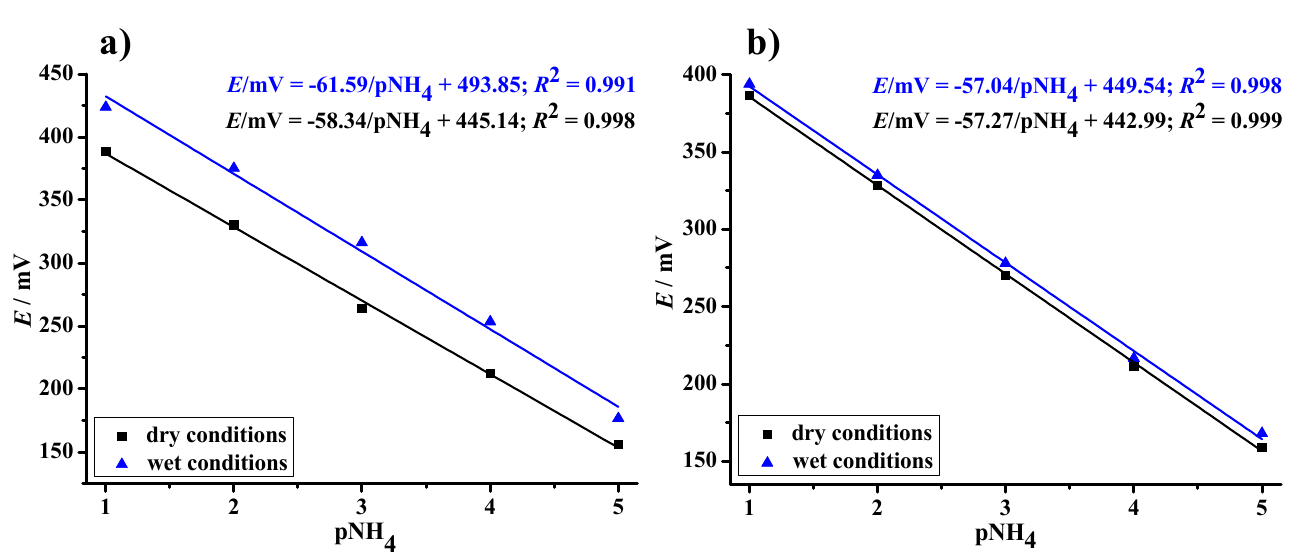
Figure 6. SEM cross-section images: ( a ) paper substrate with inkjet-printed silver line (500× magnification); ( b ) internal silver electrode coated with graphite-PVB solid-contact (500× magnification); ( c ) ammonium-selective mem- brane/graphite-PVB/silver electrode (300× magnification).